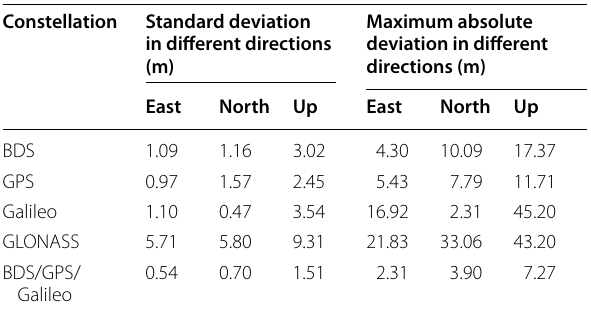
Table 4 Statistical results of smartphone positioning deviation Constellation Standard deviation in different directions